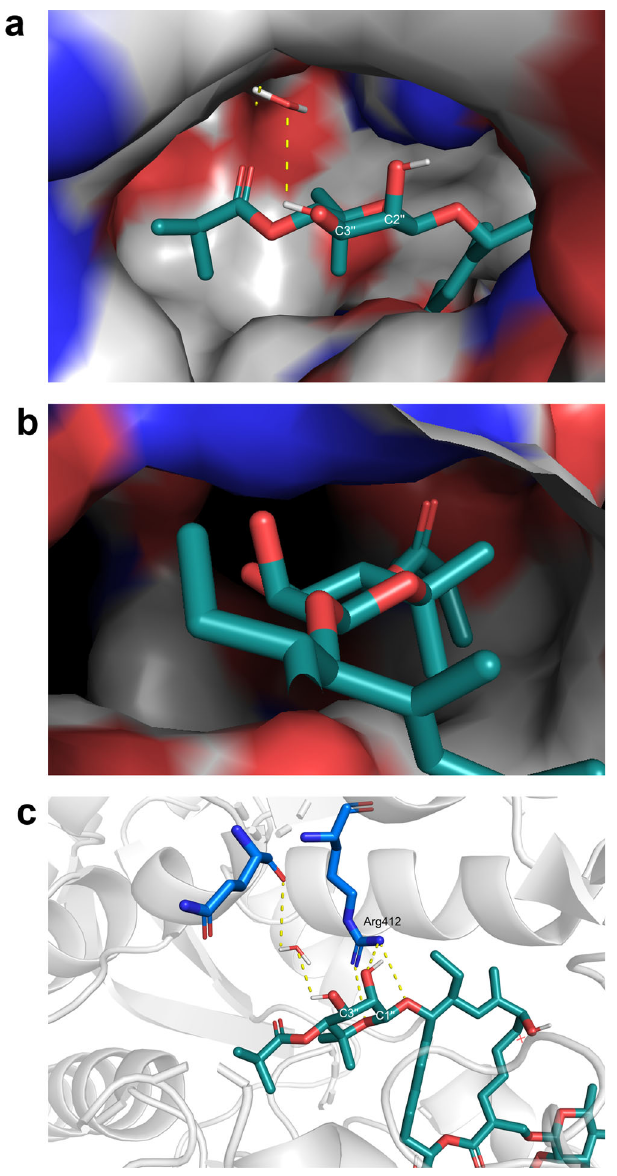
Fig. 2 Cryo-EM structure of fi daxomicin binding to M. tuberculosis RNAP (PDB ID: 6FBV) 18 . a Fidaxomicin (cyan), protein (surface representation/ gray). Interaction of C3 ” -OH with H 2 O. Limited space around isobutyric ester moiety. b Detailed view on the binding pocket of fi daxomicin ’ s noviose moiety. C3 ” -OH points toward an “ open space. ” C4 ” -isobutyric ester fi ts into its pocket. c Detailed view on the interactions of the noviose part to the protein. C2 ” -OH is blocked by an interaction with Arg412 (blue).